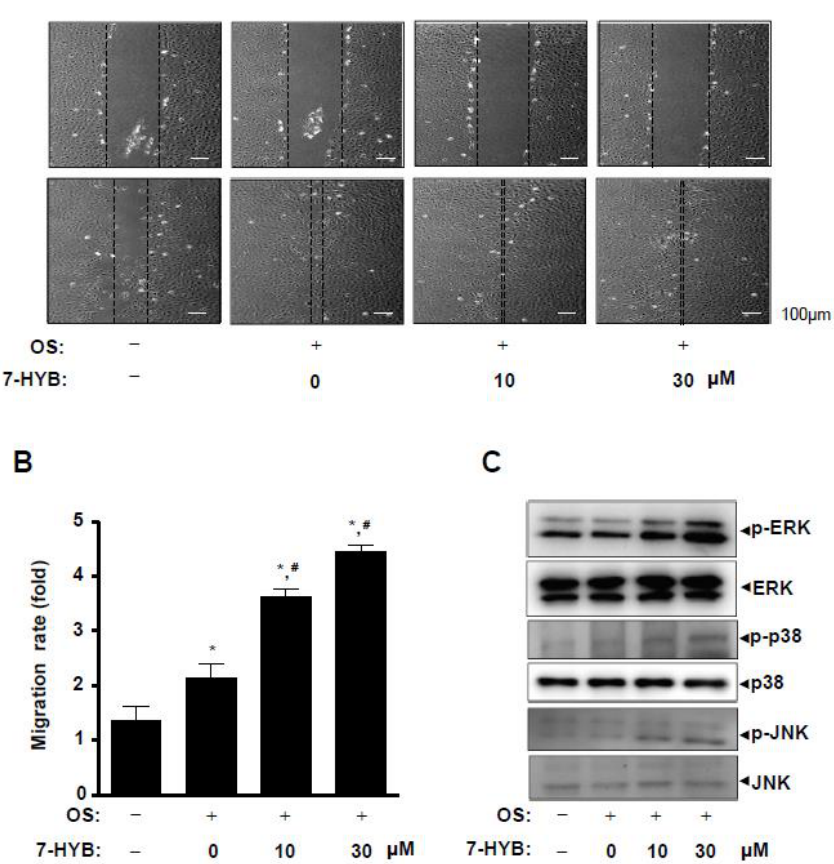
Figure 4. Effect of 7-HYB on cell migration and MAPKs signaling during osteoblast differentiation. ( A , B ) After preosteoblasts were cultured in OS with 7-HYB for 24 h, cell migration was observed under a light microscope at 0 h ( top ) and 24 h ( bottom ) ( A ), and cell migration rate (fold) was expressed as a bar graph normalized to the control ( B ). ( C ) Phospho (p)-ERK, ERK2, p-p38, p38, p-JNK, and JNK were assessed by Western blot analysis. Data represent the mean ± S.E.M. of experiments. *, p < 0.05: statistically significant difference when compared to the control. #, p < 0.05: statistically significant difference when compared to OS.